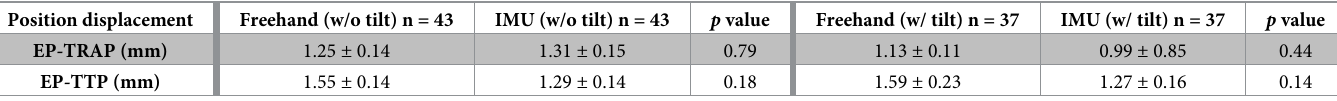
Table 2. Average differences between the postoperatively measured and planned distances between EP and TRAP or TTP. Position